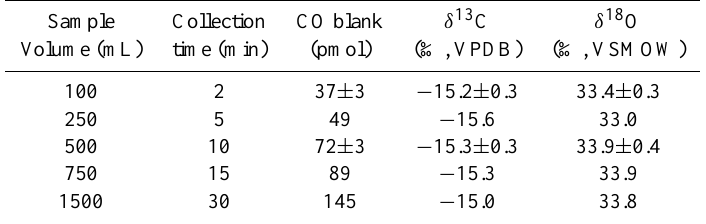
Table 1. Sch¨utze blank of the cryogenic system using zero air at a different collection time and with a flow rate of 50mL/min. Sample